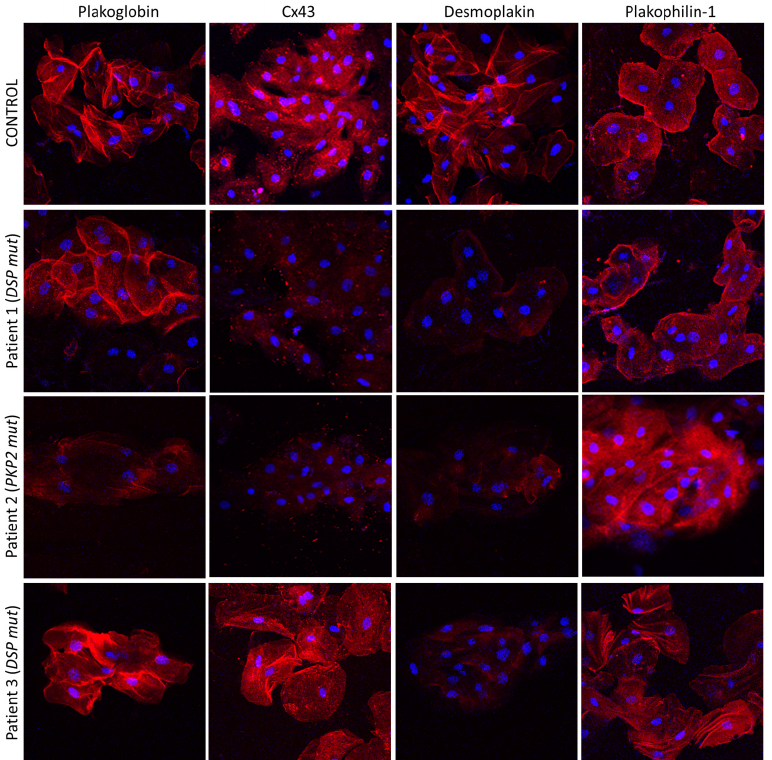
Figure 2. Confocal immunofluorescence images of buccal cells obtained from a healthy child (control) and three children with a clinical diagnosis of ACM. Patient 1 is bearing a pathogenic mutation in the DSP gene. He shows significantly reduced membrane signal for DSP and Cx43 compared to the control, but the distribution of PG and PKP1 appears to be normal. Patient 2 is carrying a pathogenic PKP2 mutation. She shows decreased localization of PG, DSP and Cx43 at the membranes, but the localization of PKP1 is indistinguishable from the control. Finally, Patient 3 carries a disease-causing mutation in DSP . DSP does not localize at the cell borders but PG, PKP1 and Cx43 do. The nuclei are stained blue with DAPI [61].